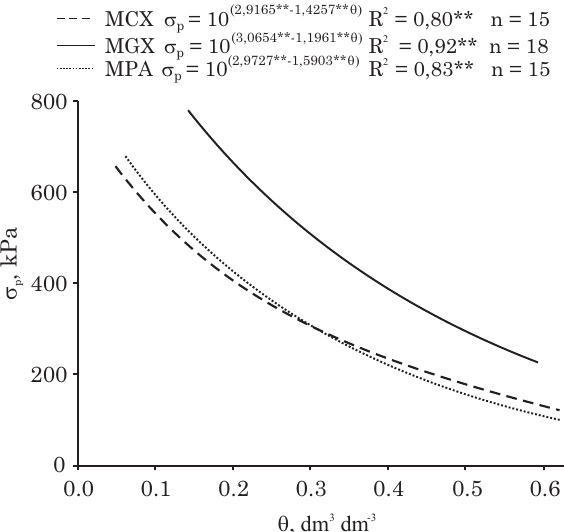
Figura 2. Modelos de capacidade de suporte de carga para um Gleissolo Háplico (MGX), Argissolo Amarelo (MPA) e Cambissolo Háplico (MCX), todos sob mata nativa, na camada de 0-5 cm, em APPs no município de Registro